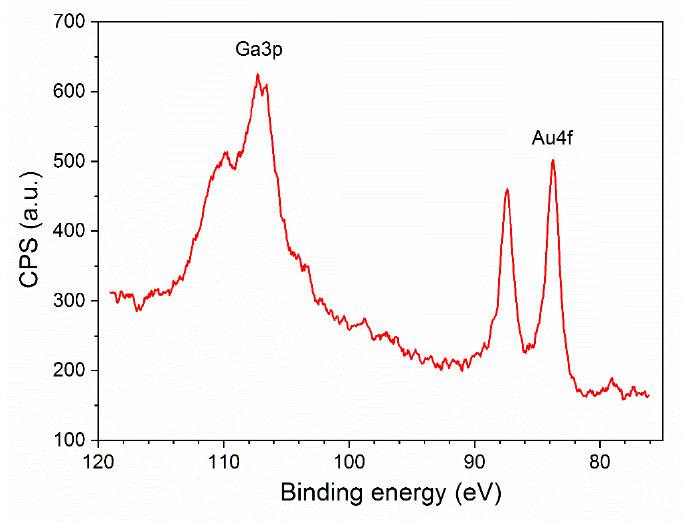
Figure 14. Core-level spectra of Au4f region.